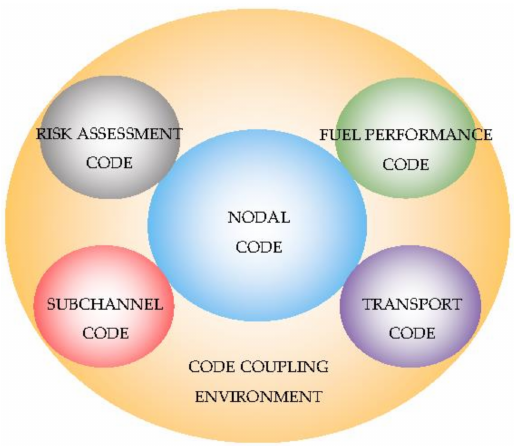
Figure 1. Multiscale and multiphysics software